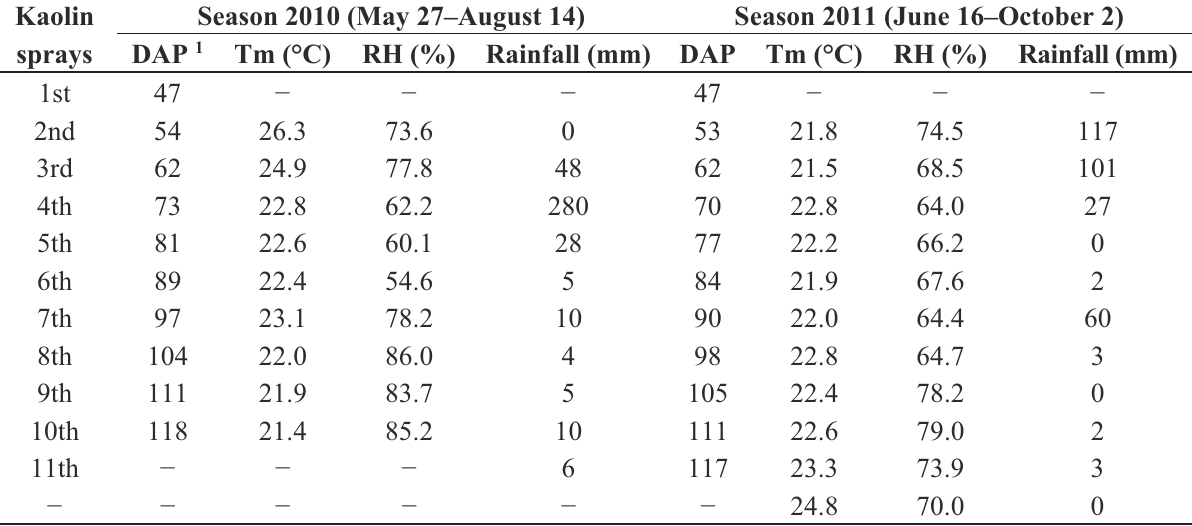
Table 1. Mean temperature (Tm), air relative humidity (RH), and rainfall during the 2010 and 2011 experimental